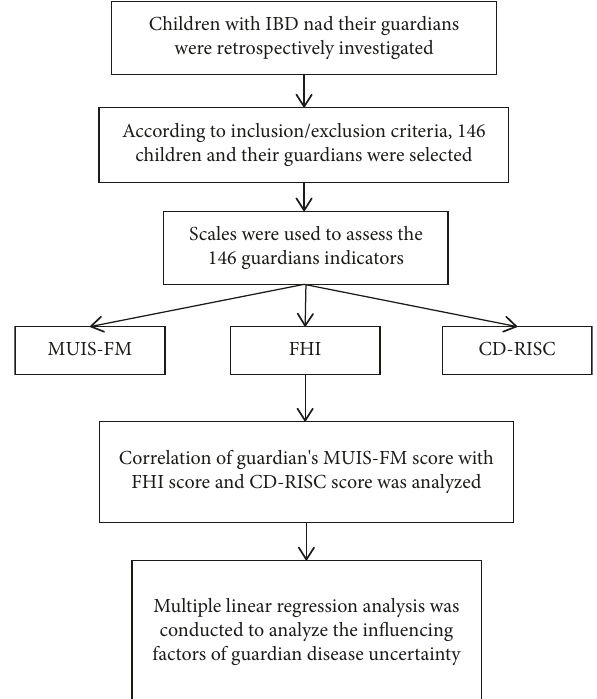
Figure 1: Method flow chart. IBD: inflammatory bowel disease, MUIS-FM: Mishel uncertainty in illness scale-family member, FHI: family hardiness index, CD-RISC: Connor–Davidson resilience scale. A total of 146 guardians of children with inflammatory bowel disease were investigated. The guardians’ sense of disease uncer- tainty, family strength, and mental resilience were evaluated by MUIS-FM, FHI, and CD-RISC, respectively. These analyzed the correlation of MUIS-FM between FHI and CD-RISC, and the influencing factors of uncertainty in illness were analysed by multiple linear